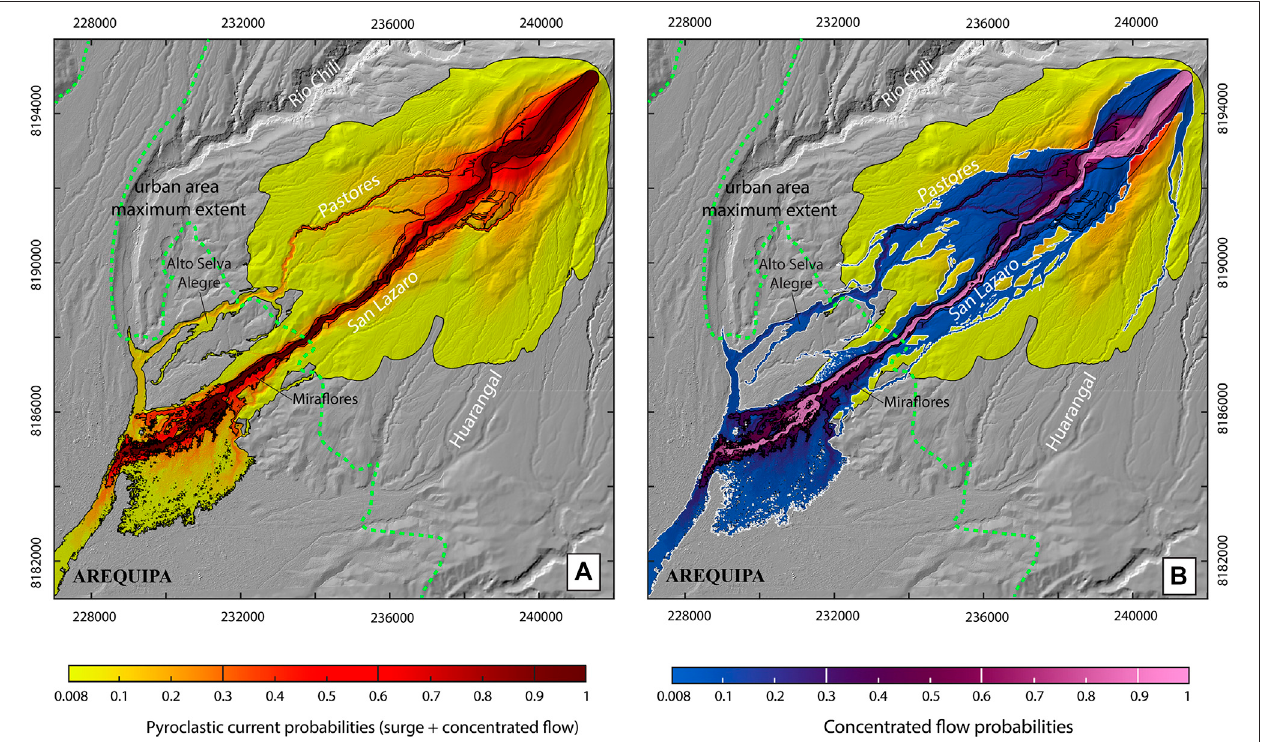
FIGURE 8 | VolcFlow probabilistic map for a pyroclastic current in the San Lázaro drainage basin, made by calculating the number of hits at each digital surface model cell for 123 numerical simulations. Map (A) shows the probabilities for the entire pyroclastic current (i.e., dilute + concentrated parts) with a yellow to red color scale. Map (B) distinguishes the probabilities of a concentrated pyroclastic current with ablue to pink color scale, from the dilute pyroclastic current, with a yellow to red color scale. Iso-probability contour lines at every 0.3 probability intervals are also included. The green dashed linecorresponds to maximum extent ofthe Arequipa urban